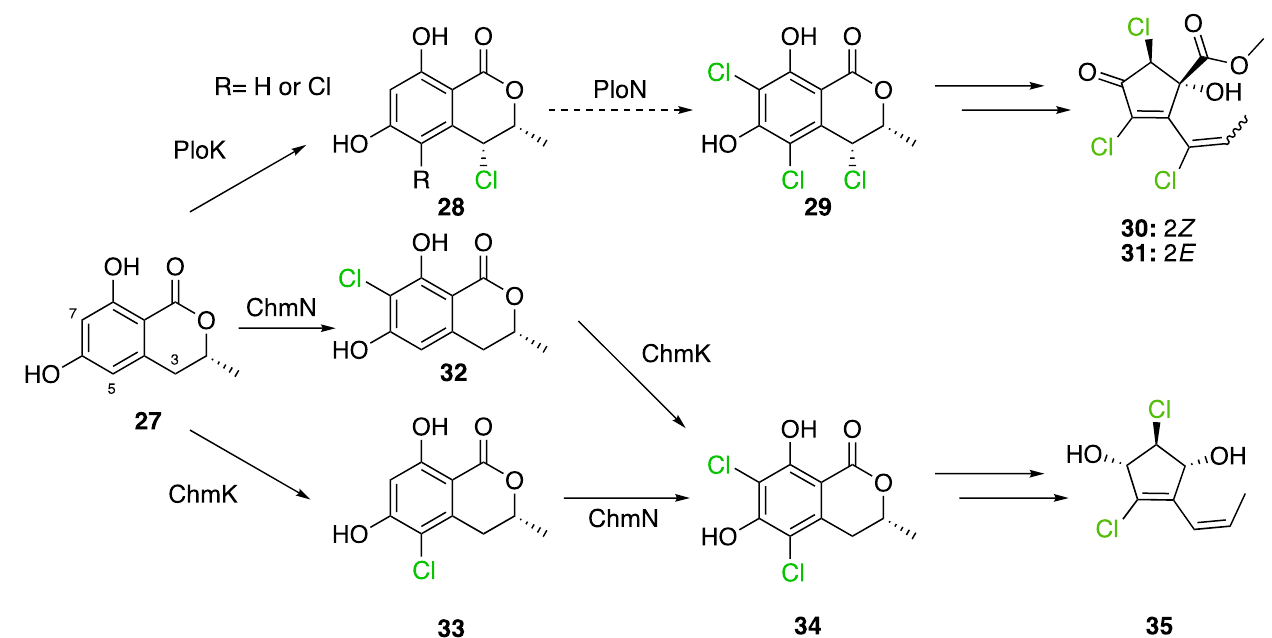
Figure 19. Halogenation of ( R )-6-hydroxymellein ( 27 ) by PloK and PloN in L. palmae, and in H. velutinum by ChmK and ChmN. If R = H, (2 R ,3 R )-3-Chloro-6-hydroxymellein, if R = Cl, (2 R ,3 R )-3,5-Dichloro-6-hydroxymellein ( 28 ). (2R,3R)-3,5,7-Trichloro-6-hydroxymellein ( 29 ), palmaenone A ( 30 ), palmaenone B ( 31 ). ( R )-7-Chloro-6-hydroxymellein ( 32 ), ( R )-5-chloro-6-hydroxymellein ( 33 ), ( R )-5,7-dichloro-6-hydroxymellein ( 34 ), and cyclohelminthol IV ( 35 ). For palmaenone biosynthesis, PloK first catalyzes mono or dichlorination on C3 and